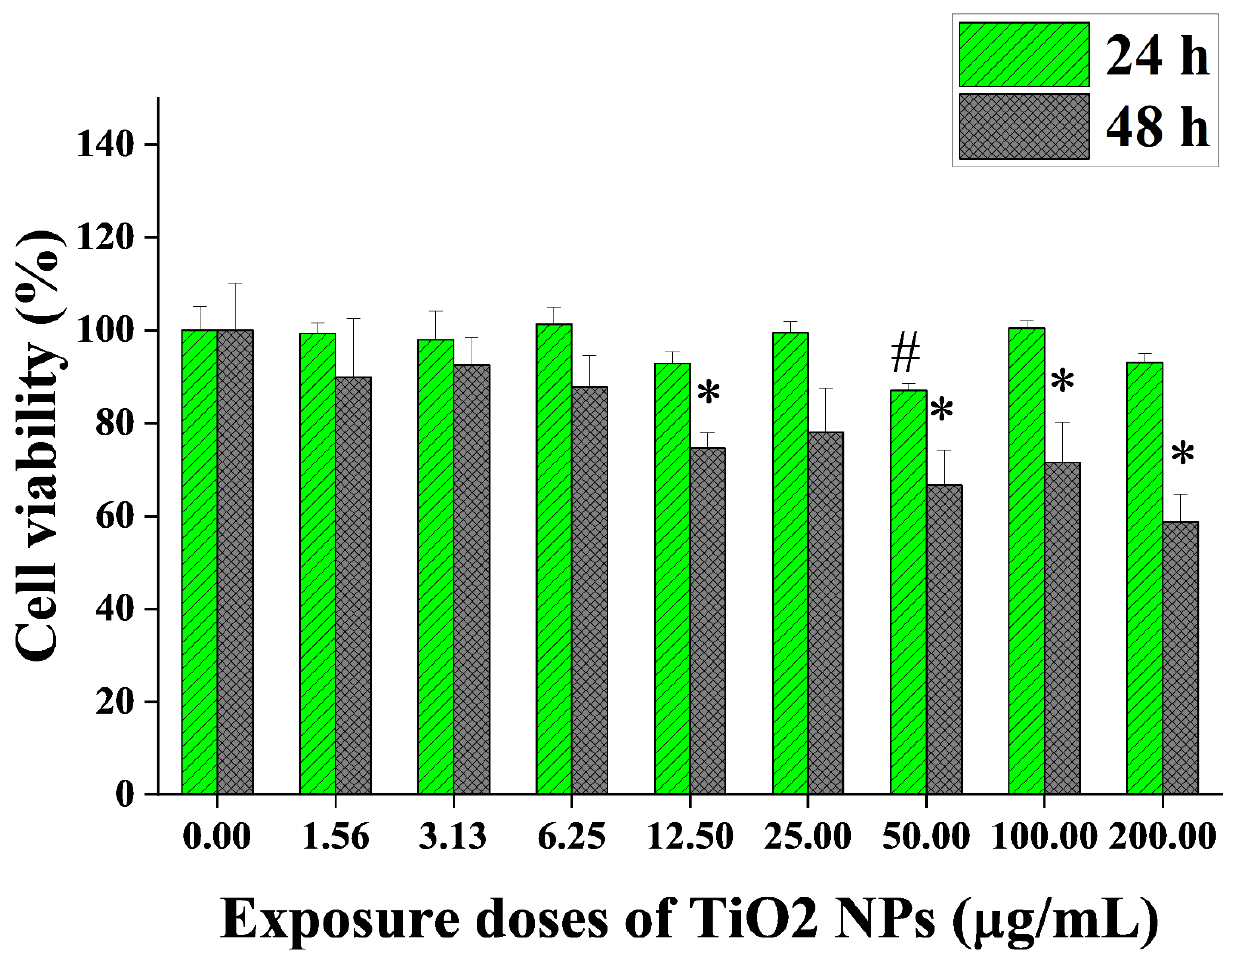
Figure 2. Cytotoxicity induced by TiO 2 NPs in BEAS-2B cells (mean ± SD, n = 3). BEAS-2B cells were exposed to 0 – 200 µg/mL TiO 2 NPs for 24 h and 48 h. Significant difference from the control group for 24 h exposure (# p < 0.05); significant difference from the control group for 48 h exposure (* p < 0.05).